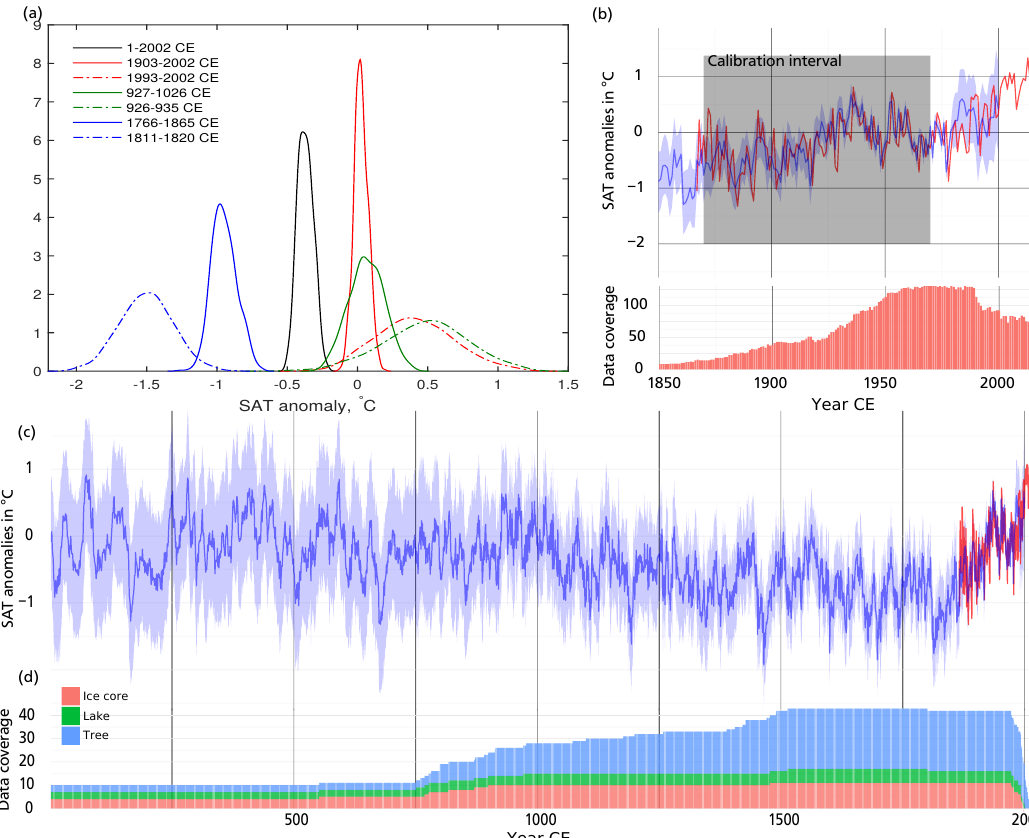
Figure 2. (a) Ensemble-based mean Arctic summer (June–August) SAT (land only) anomaly probability density for the three selected centennial-scale and three-decade-scale time periods. The periods presented correspond to the coldest and warmest century- and decade- long periods of the LIA and MCA together with the Contemporary Warm Period. The actual probability densities are estimated using the Gaussian kernel density function. (b) Arctic (land only) average summer temperature anomalies over the instrumental period and number of instrumental observations available. The grey box denotes the calibration interval. (c) Ensemble-based spatially averaged time variability in the seasonal SAT probability distribution over the reconstruction period. Blue line: ensemble mean; shading: (pointwise) 95% posterior; red line: instrumental data. Note that before 1870CE the number of instrumental observations rapidly decreases. (d) Number of proxies by archive type over